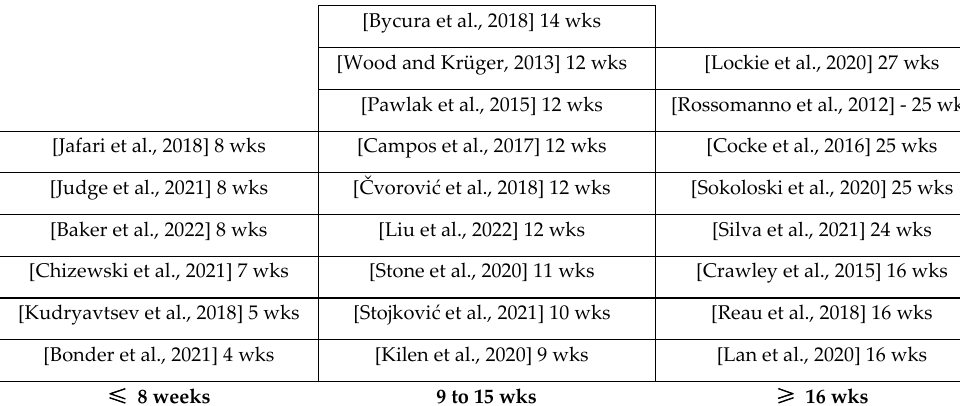
Figure 2. Physical training programs duration (in weeks; wks).